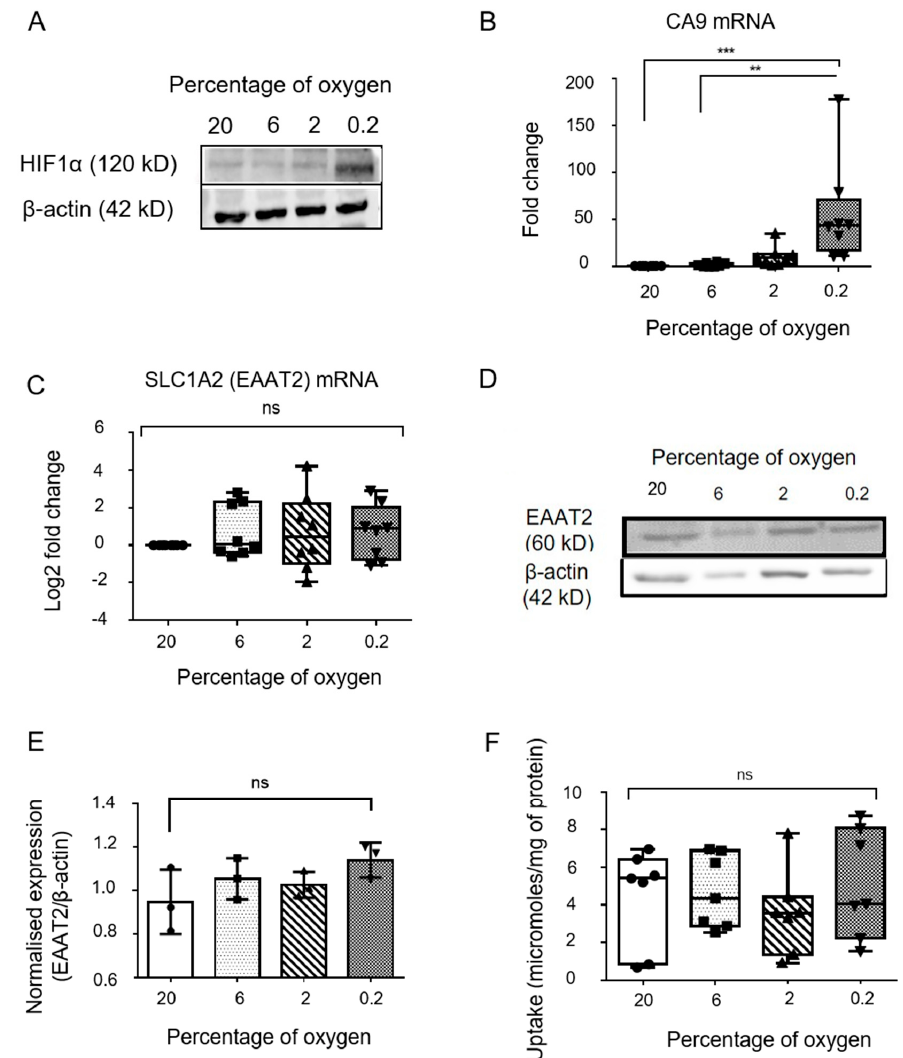
Figure 4. Hypoxia treatment to differentiated astrocytes. ( A ) Western blot image for Hypoxia-inducible factor 1 α (HIF1 α ) expression in astrocytes exposed to various grades of hypoxia. ( B ) Car- bonic anhydrase 9 (CA9) and ( C ) SLC1A2 (EAAT2) gene expression in astrocytes exposed to various grades of hypoxia as analysed by qPCR (n = 8). ( D ) Representative western blot picture and ( E ) quantification of western blot data showing expression of EAAT2 in various grades of hypoxia (n = 3). ( F ) Box and whisker plot showing glutamate uptake by astrocytes exposed to different concen- trations of oxygen (n = 7). Data represented as Mean ± SD. ** p -value < 0.01, *** p -value < 0.001, ns: non-significant.